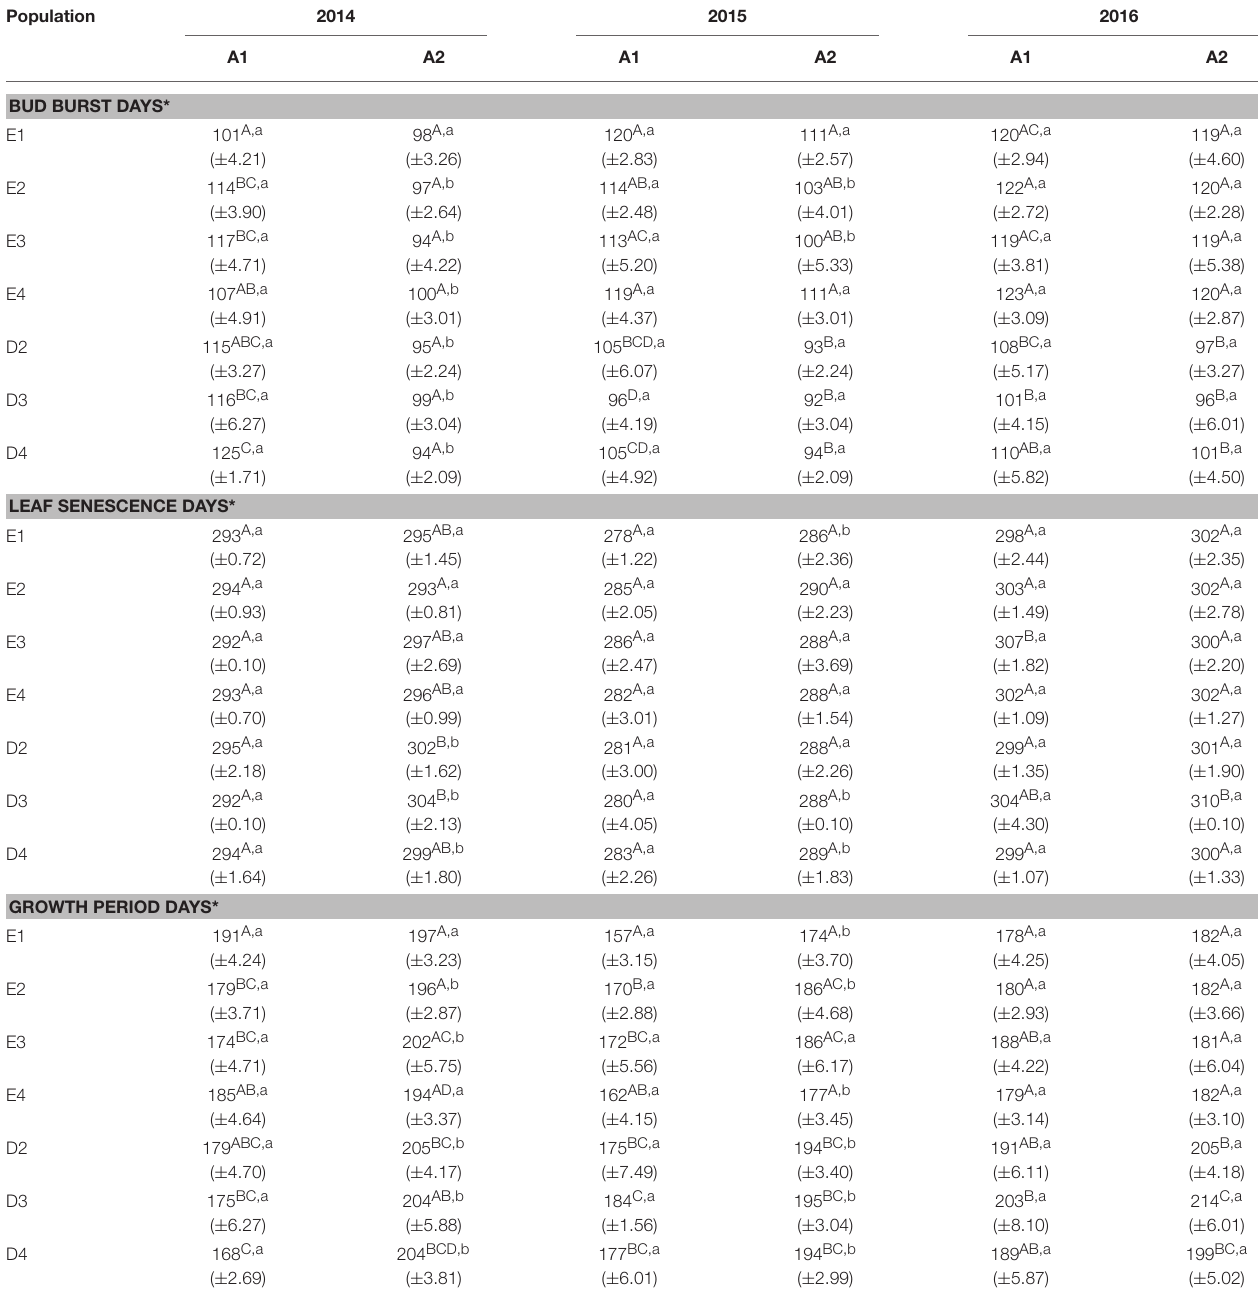
TABLE 6 | Phenology of seedlings under irrigation schemes for the years of study (Mean values ±